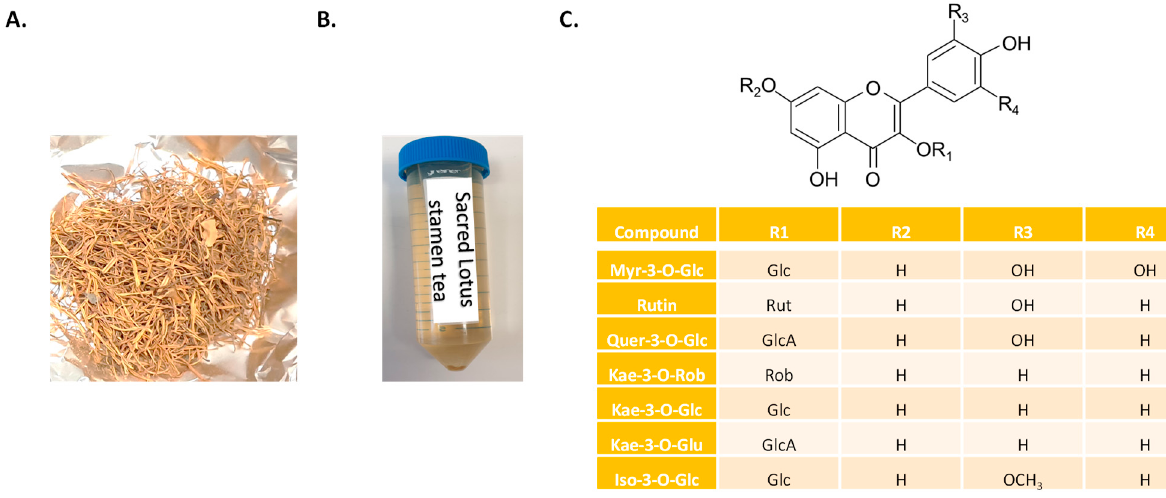
Figure 1. Pictures of sacred lotus ( N. nucifera ) stamen ( A ) and tea obtained after traditional infusion ( B ) and chemical structures of its main flavonoids ( C ) Myr-3-O-Glc: myricetin-3-O-glucose; Quer-3-O-Rut: quercetin-3-O-rutinoside (rutin); Quer-3-O-GlcA: quercetin-3-O-glucuronic acid; Kae-3-O-Rob: kaempferol-3-O-robinobiose; Kae-3-O-Glc: kaempferol-3-O-glucose; Kae 3-O-GlcA: kaempferol 3-O-glucuronic acid; Iso-3-O-Glc: isorhamnetin-3-O-glucose; Glc: glucose; GlcA: glucuronic acid; Rob: robinobiose.